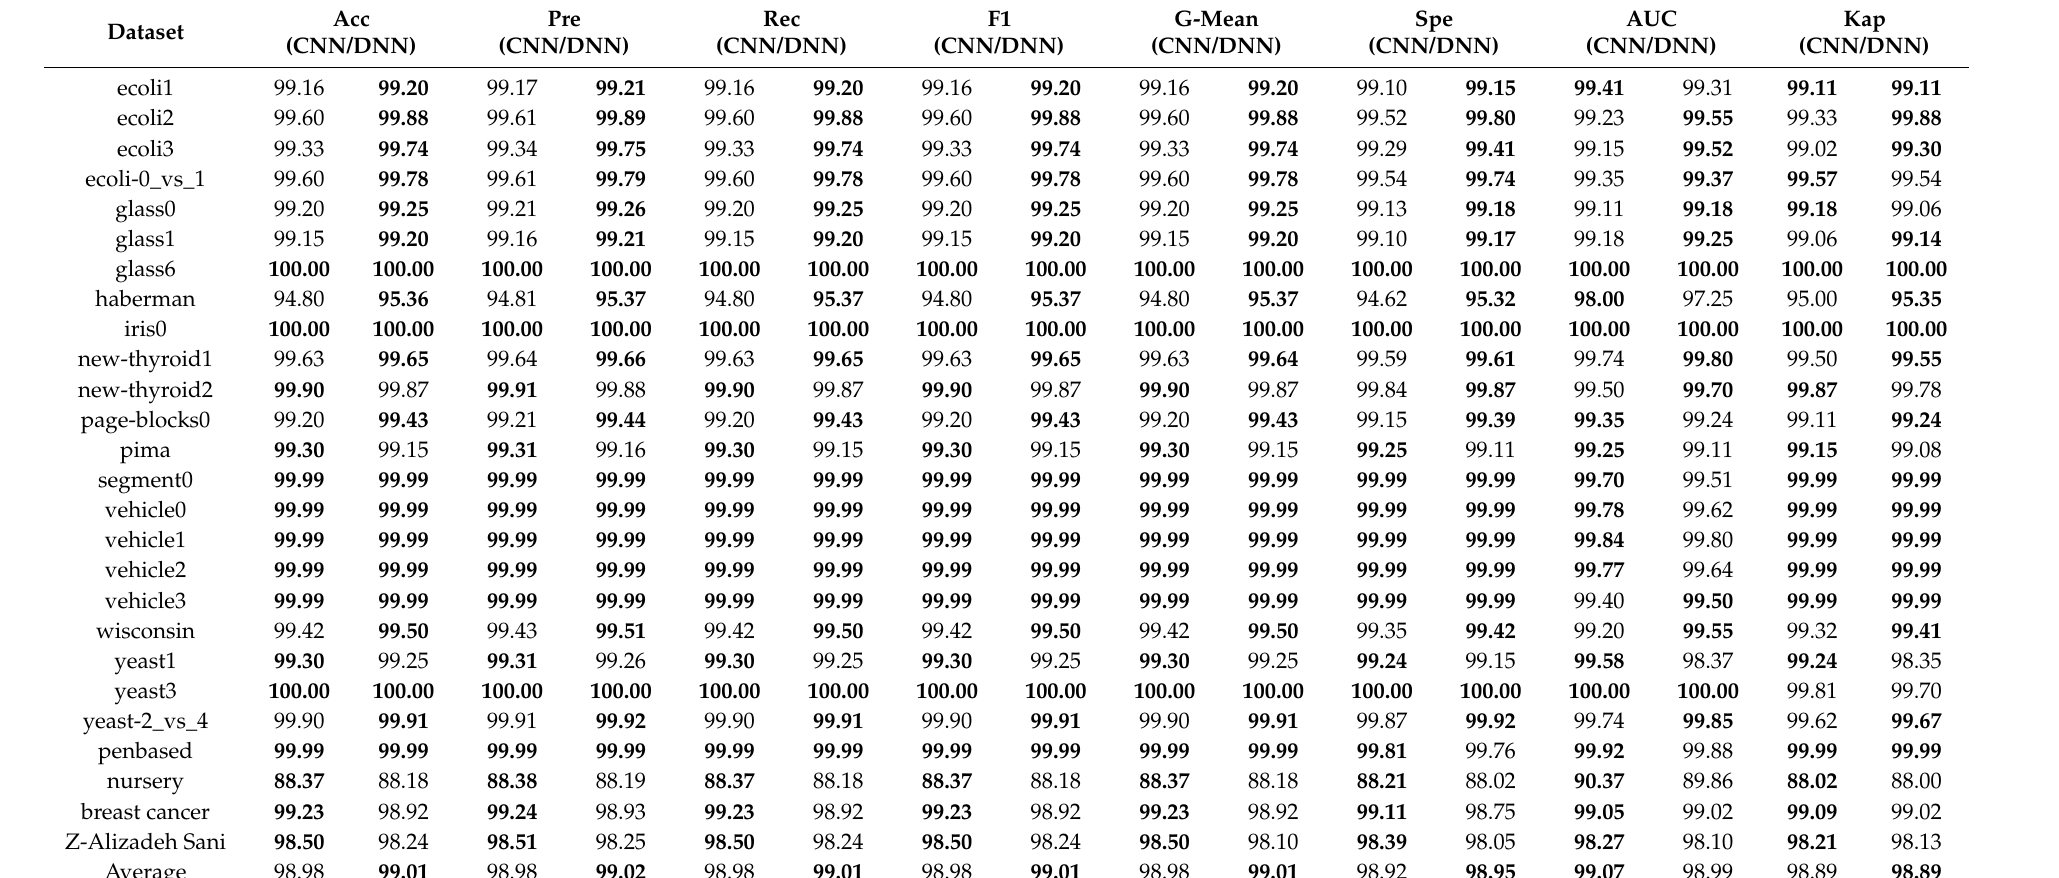
Table 9. NearMiss + NORM. +